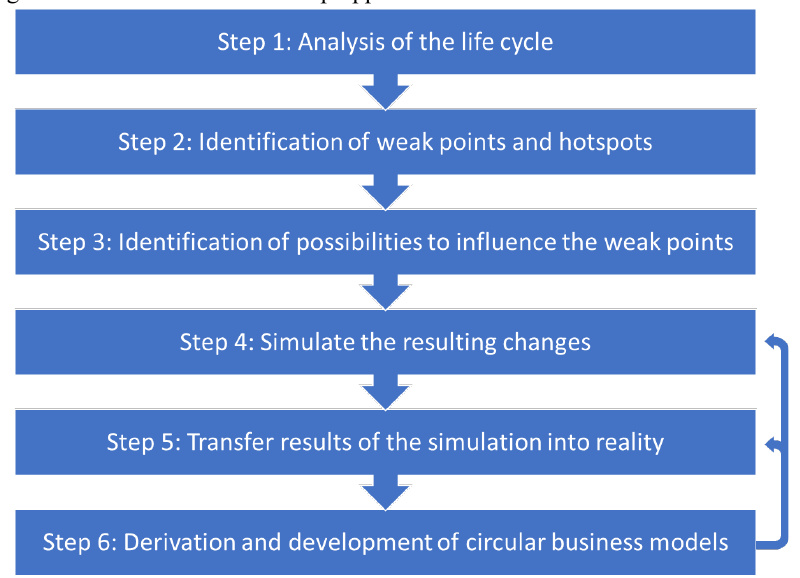
Figure 3. Overview of the